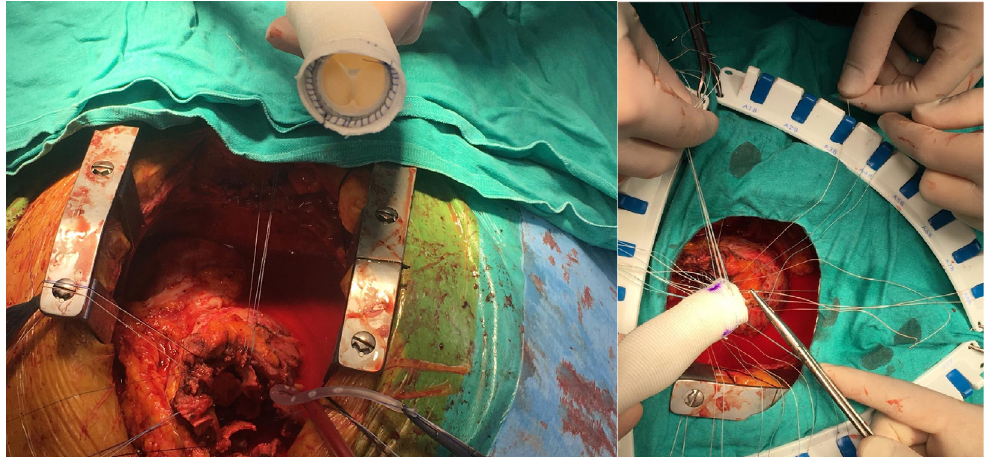
Fig. 1 - Preparation of Dr. Yakut’s flanged Bentall